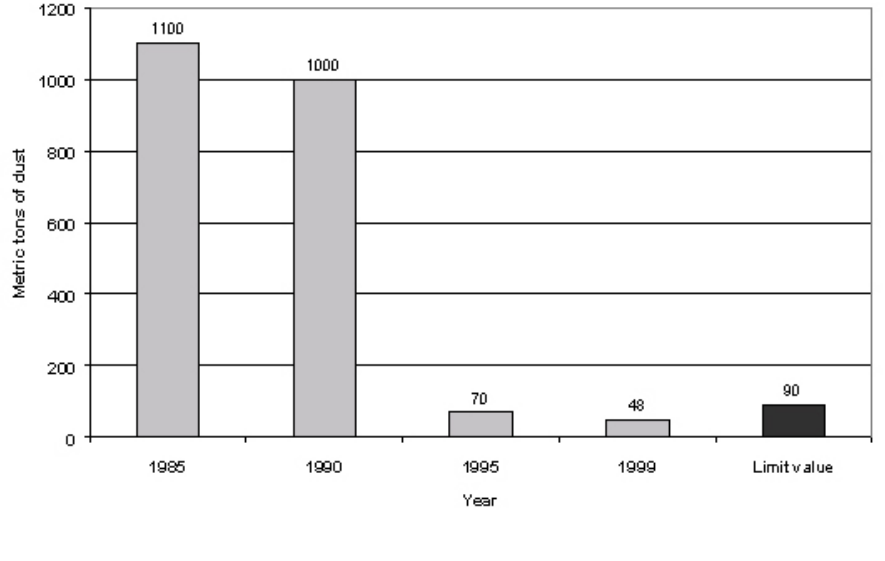
FIGURE 2 . Dust emissions to the atmosphere from copper smelter in